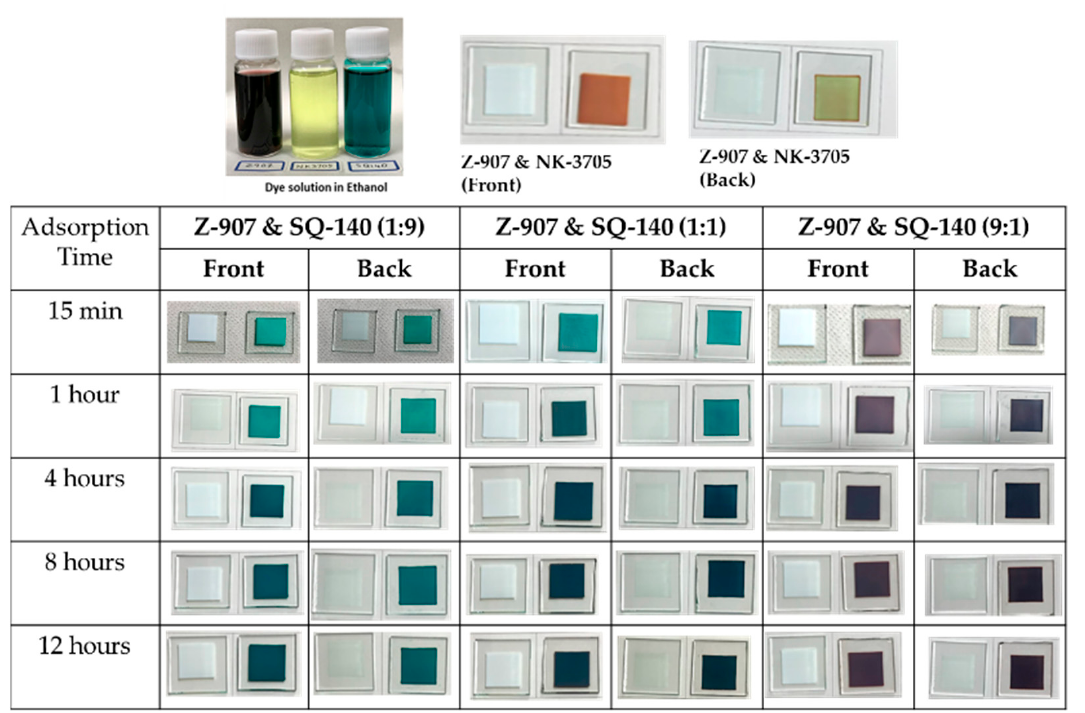
Figure 5. Photographs of the adsorption behaviour of dyes using dye cocktails of two sensitizing dyes with varying molar ratios on the mesoporous TiO 2 .